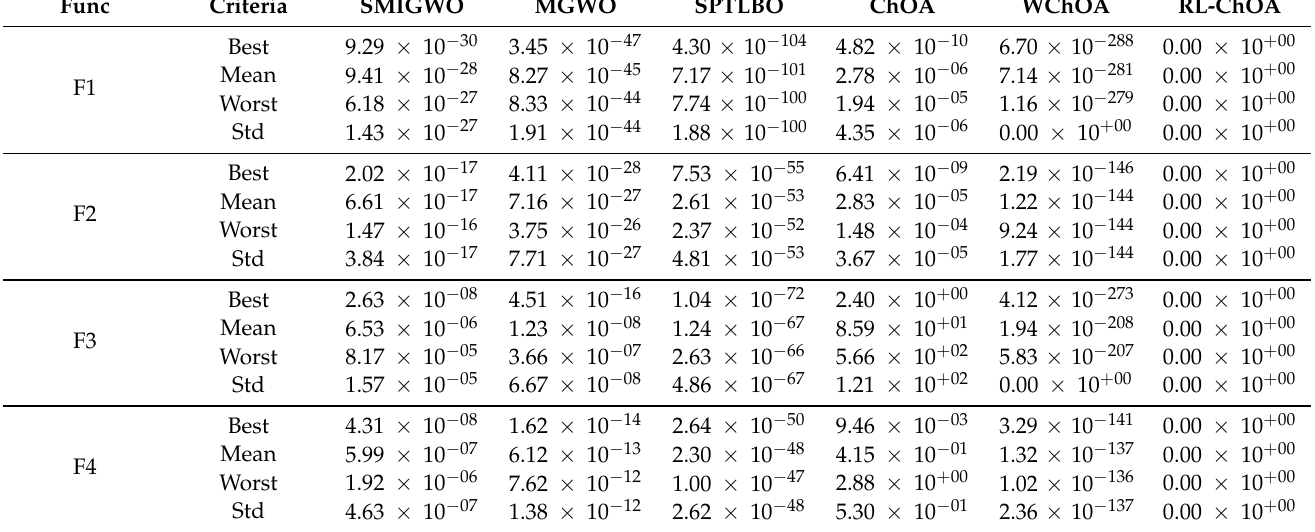
Table 2. Results of unimodal benchmark test